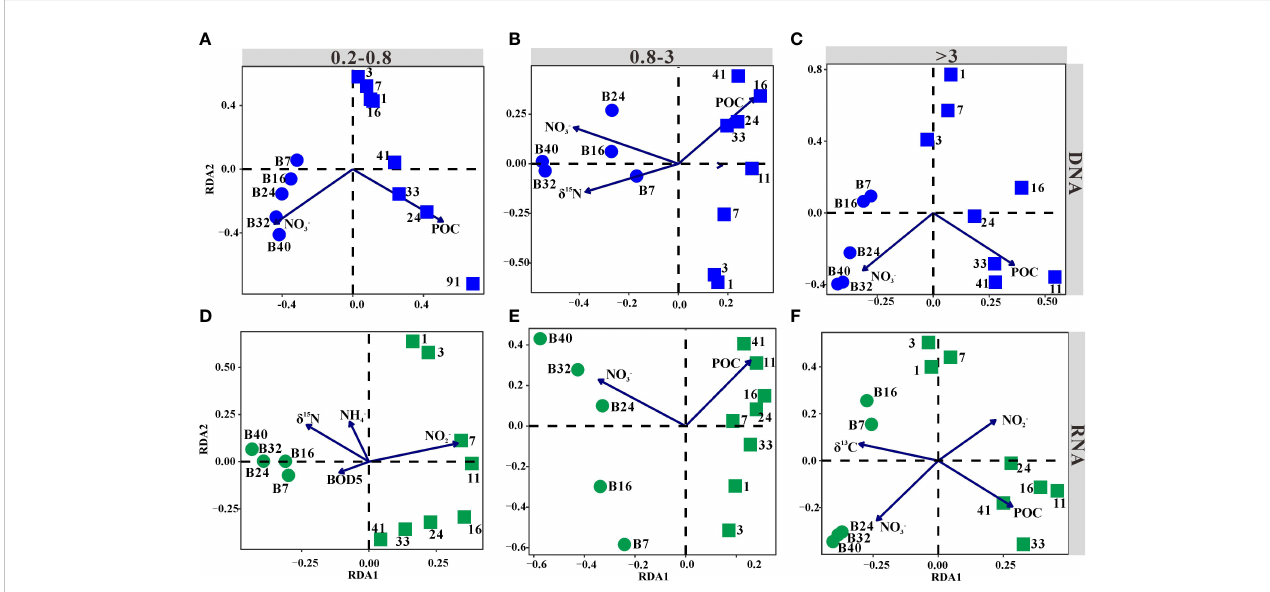
FIGURE 2 Ordination plots of the results from the redundancy analysis (RDA). Blue points represented DNA libraries, while green points represented RNA libraries. Communities were from the 0.2 – 0.8- m m (A, D) -, 0.8 – 3- m m (B, E) -, and >3- m m (C, F) -size fractions (p < 0.05). The circle and square represented samples collected before and after the addition of freshwater,